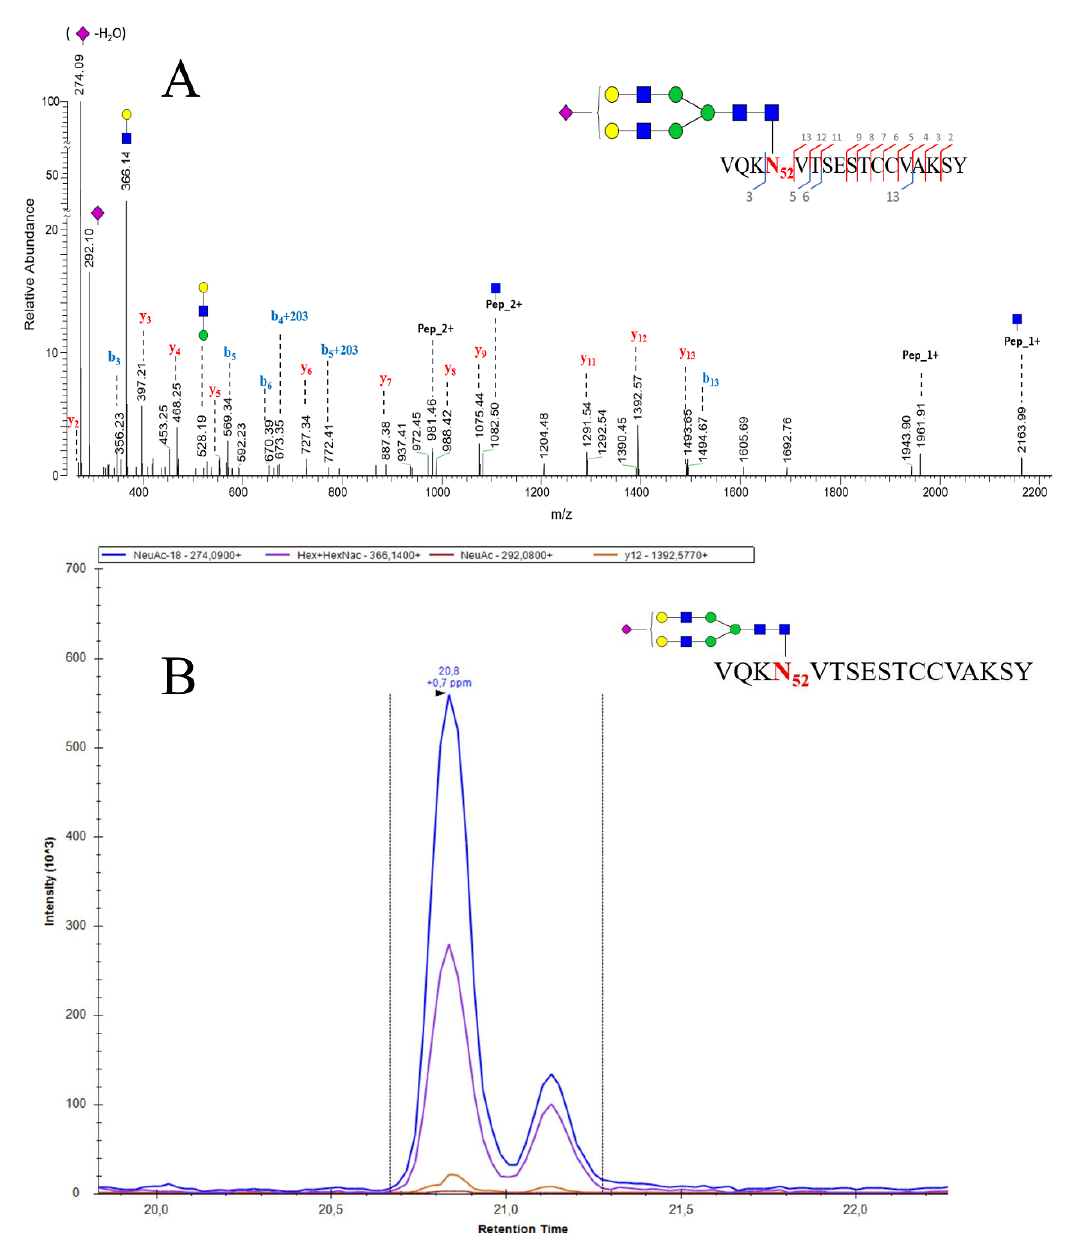
Figure 3. High-energy collision dissociation (HCD) fragmentation of the L.VQKN 52 VTSESTCCVAKSY.N glycopeptides with mono sialylated complex glycan at Asn 52 ( A ) and EIC chromatogram ( B ) of the same glycopeptides (the two peaks are due to the different conformational isomers of the glycosidic structure [HexNac4Hex5NeuAc1]). represents N - acetyl-glucosamine; represents mannose; represents galactose; represents c sialic acid. The fragmentation pattern of high-energy collision dissociation (HCD) is an alternative type of fragmentation method characterized by higher activation energy and shorter activation time comparing to the traditional ion trap CID (Figure 4). HCD for peptides with posttranslational modifications (PTMs) can provide both the sequence information (b- and y-type fragment ions) and the localization of the modification sites as it can identify CID-labile PTMs. Thus, high mass accuracy MS2 spectra have been successfully applied for PTMs studies, as certain diagnostic ions specific for HCD could be recognized for PTMs identification [138].